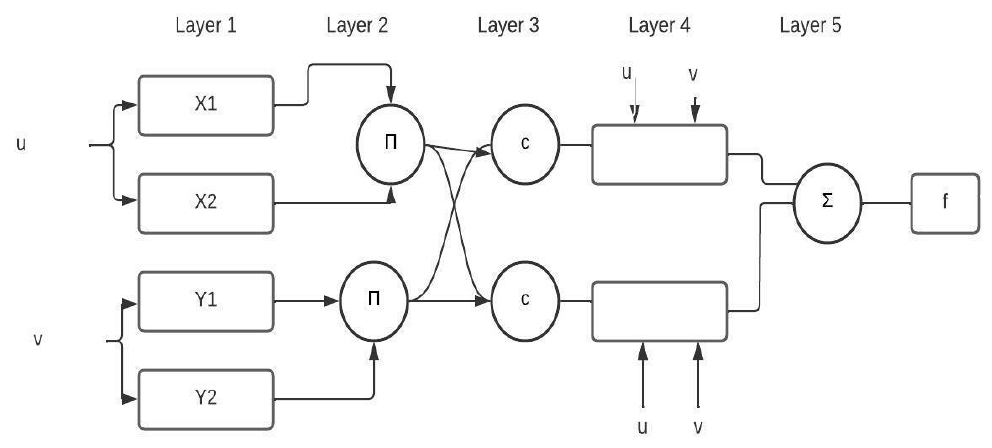
Figure 1. The architecture of ANFIS model.